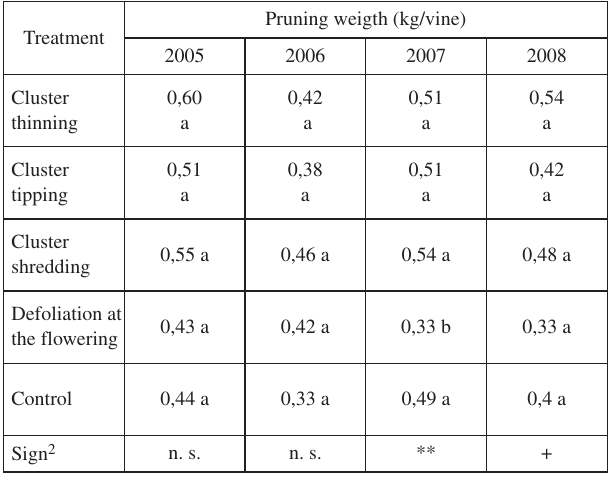
Table 1. Effect of the treatments on the pruning weigth from cv. Kékfrankos, 2005–2008.